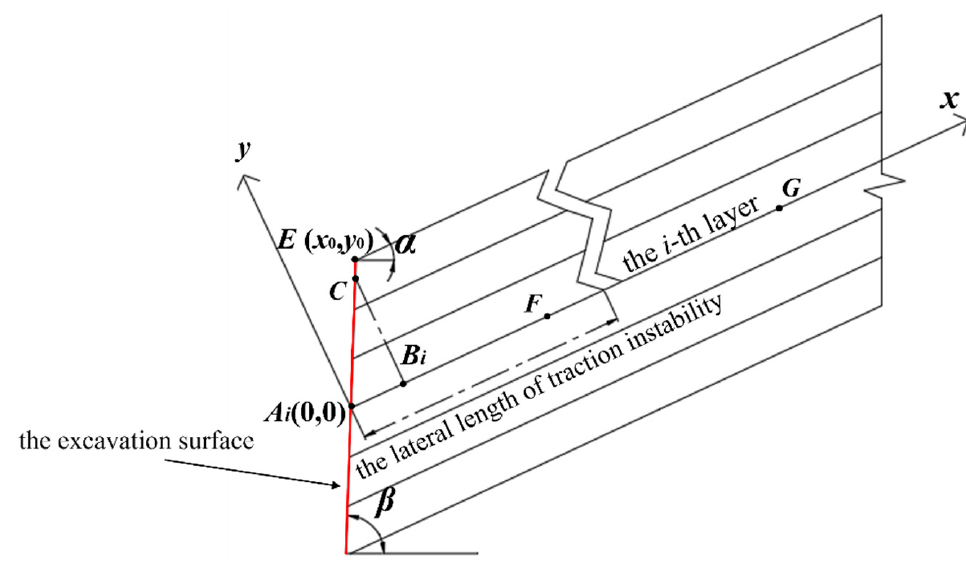
Figure 12. Slope calculation model.